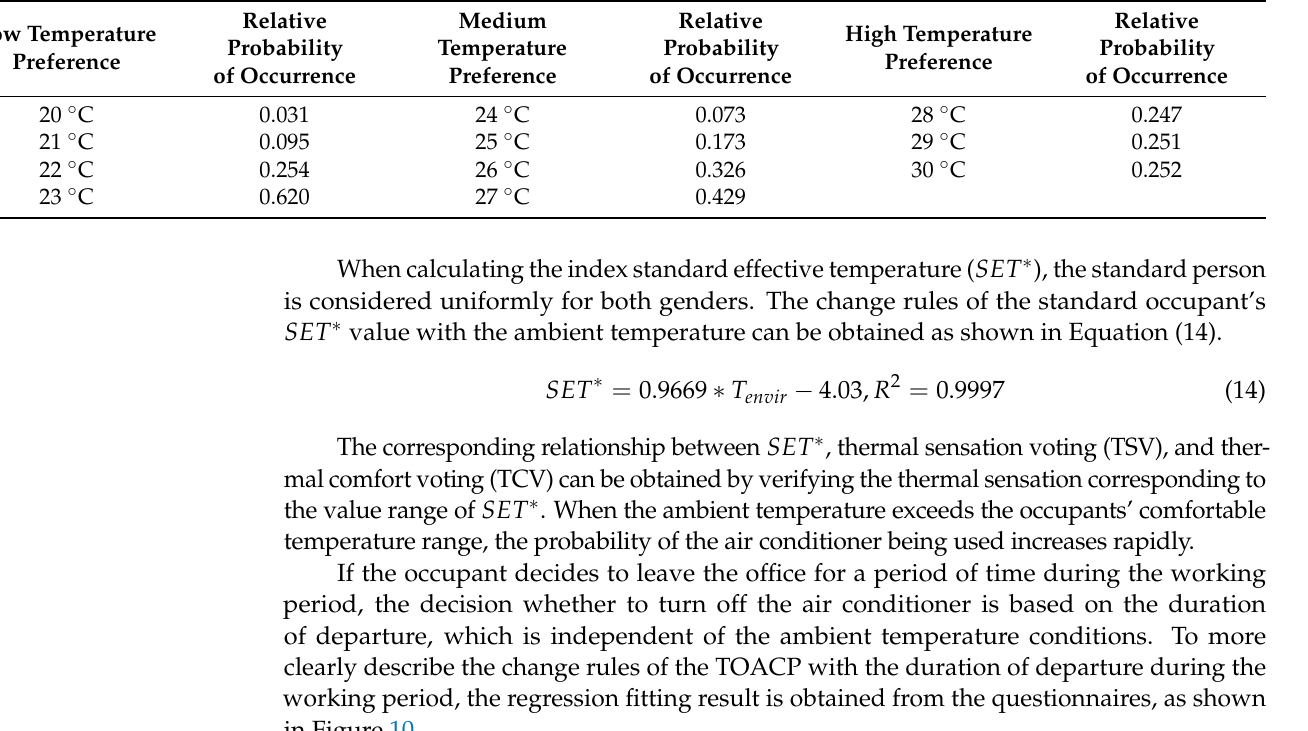
Table 6. Relative probability of the occurrence of different air conditioning temperature setting preferences.